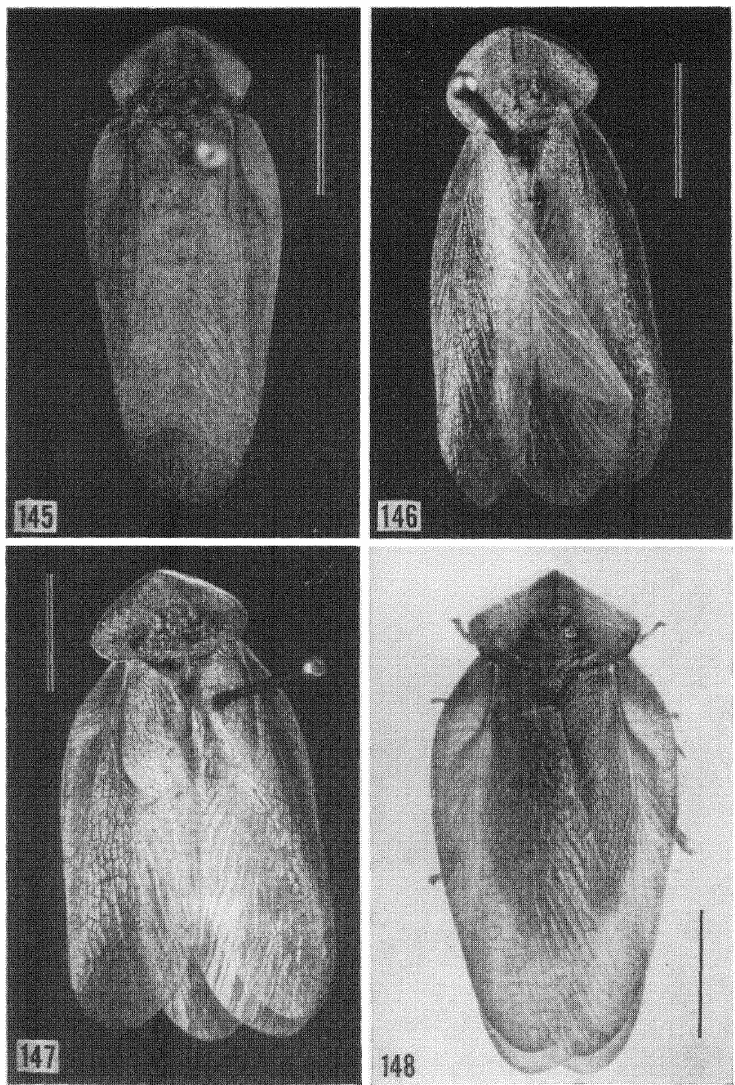
Figures 1/5-148. Adult males of guluia spp. 145. (1408 L). Z. litho- strota Rehn. Letsletle Valley, Gravelotte Dist., South African Transvaal (det. Prineis). 146. (154 ANSP). g. Iubescens (Sauss.). Durban, paratype of g. mitella Rehn. 147. (145 ANSP). g. abscissa (Walker). Durban (det. Rehn; Prineis [1960, p. 141] states that Rehn’s identification of ab- scissa was an error and that the specimen was Z. lithostrota Rehn. The L2d of this specimen (Fig. 158) is more like that of abscissa (Fig. 155) than lithostrota (Fig 149)). 148. (1407 L). Z. abscissa (det. Prineis). (scale 5